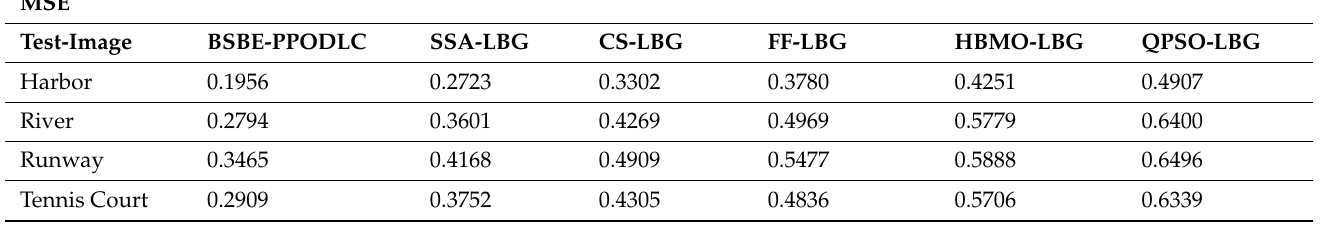
Table 2. MSE analysis results of the proposed BSBE-PPODLC method with other methods for distinct test images.